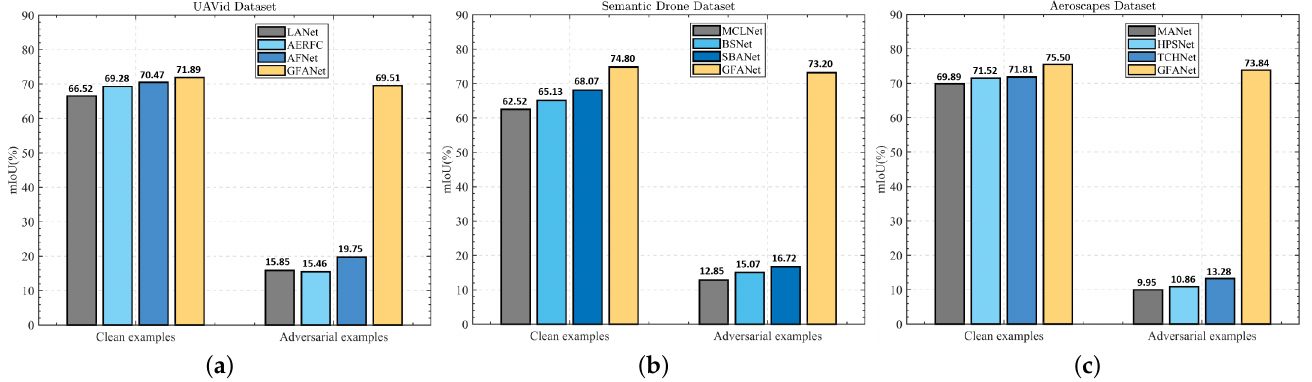
Figure 6. Quantitative comparison results of calean examples and adversarial examples on different datasets. ( a ) UAVid dataset [2]. ( b ) Semantic Drone dataset [70]. ( c ) Aeroscapes dataset